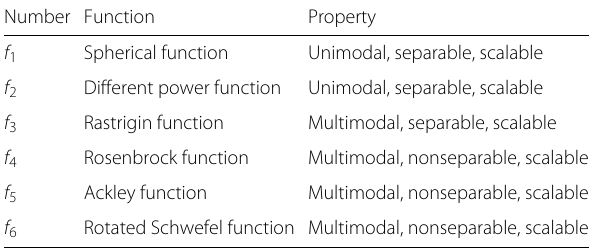
Table 1 Mathematical functions: two unimodal functions and four multimodal